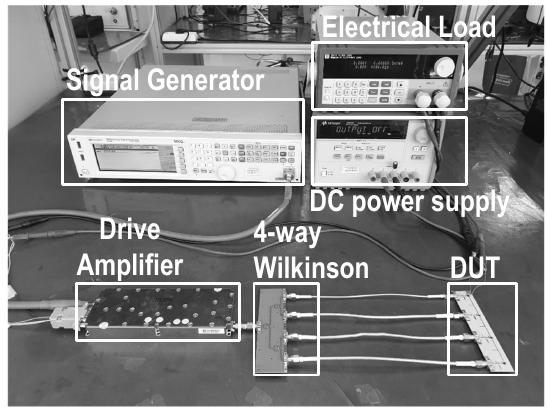
Figure 12. A photograph of the measurement